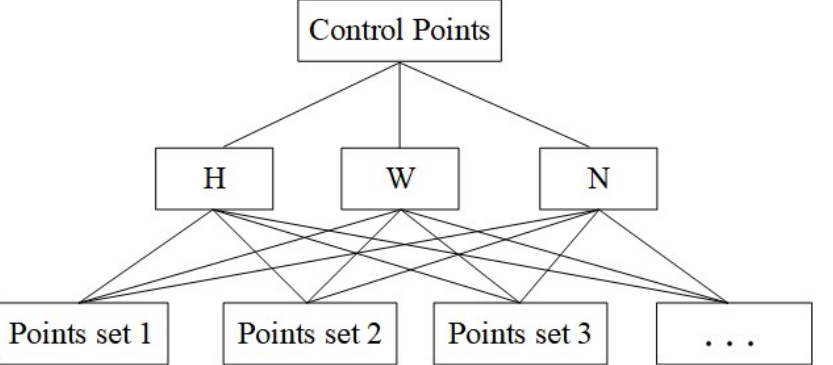
Figure 10. Hierarchical structure. The top level is the target level, the middle level is the criterion level, and the bottom level is the scheme level.